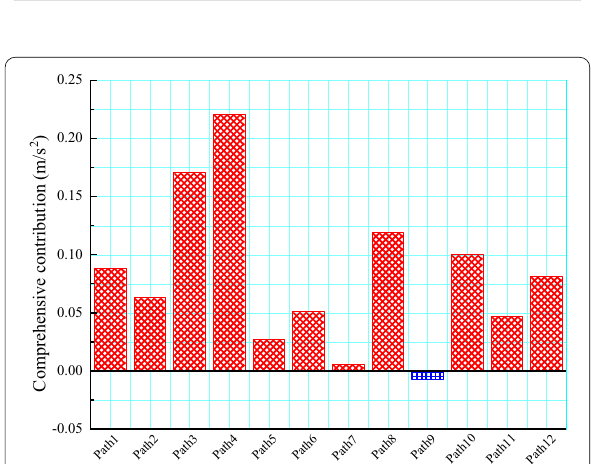
Figure 11 a Amplitude–frequency and b phase–frequency relationship